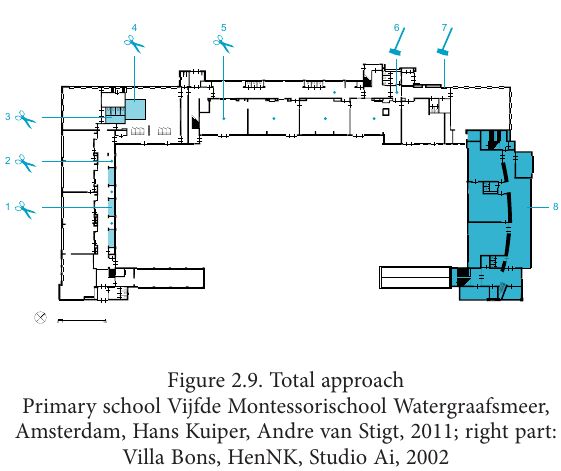
Figure 2.9. Total approach